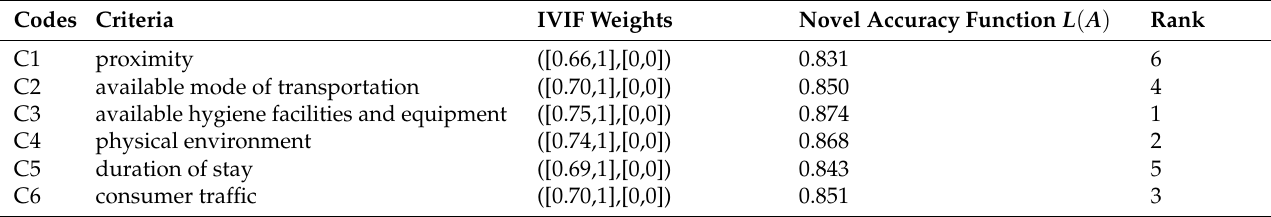
Table 11. The IVIF weights of the evaluation criteria of restaurants.